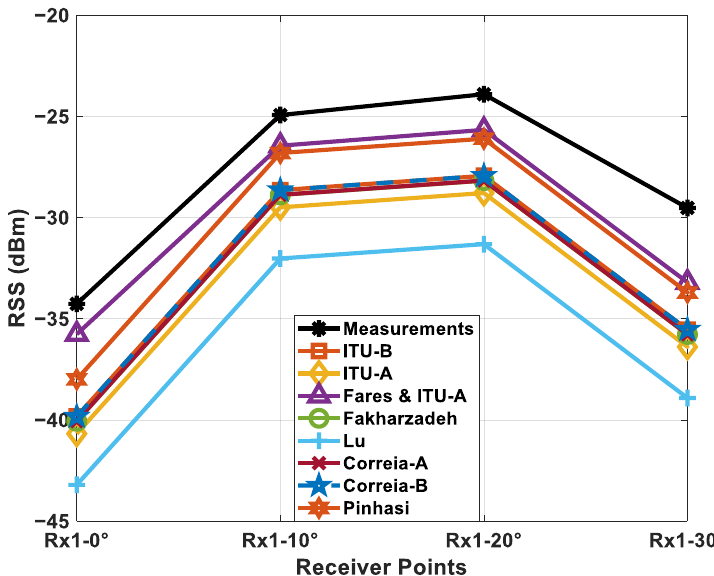
Figure 10. Performance comparison between measurements and data taken from references at Rx1.